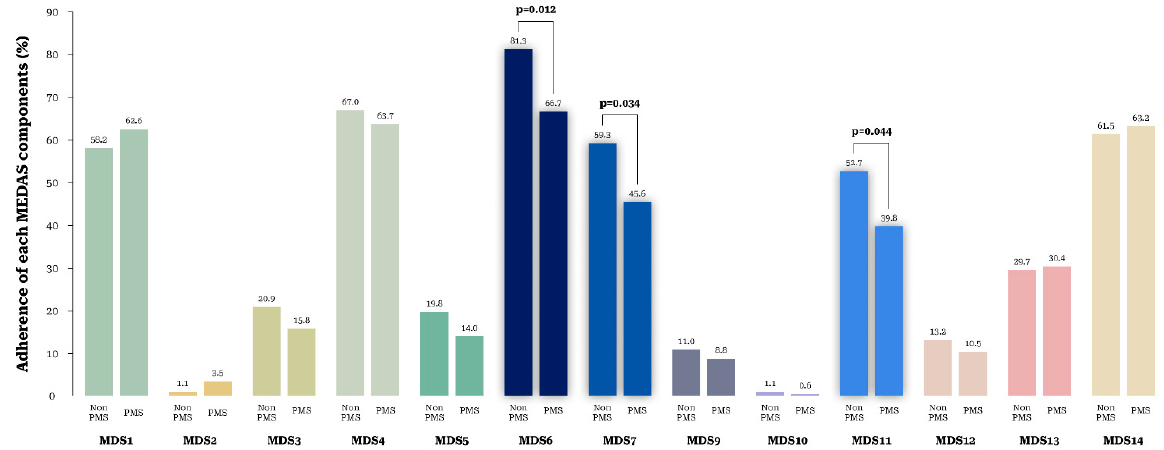
Figure 2. Proportion of participants without and with PMS according to adherence to each of the 14 components of the Mediterranean diet score. Table 4. Weekly consumption frequency (times/week) of food groups by PMS group.